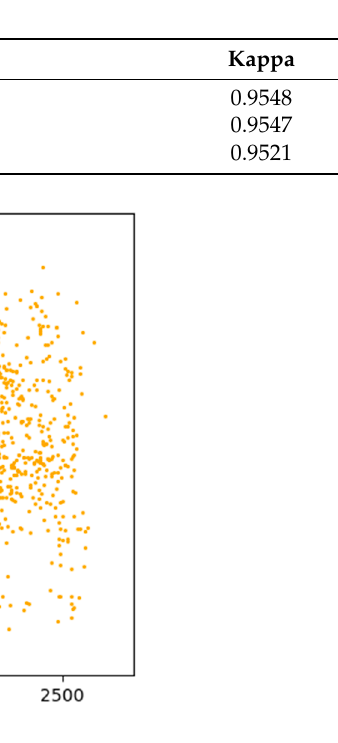
Figure 6. The water body and shadow samples in the two-dimensional space of elevation and slope. The number of water body and shadow samples were 23,265 and 41,214. Table 3. The schematic table of mountain shadow removal methods.